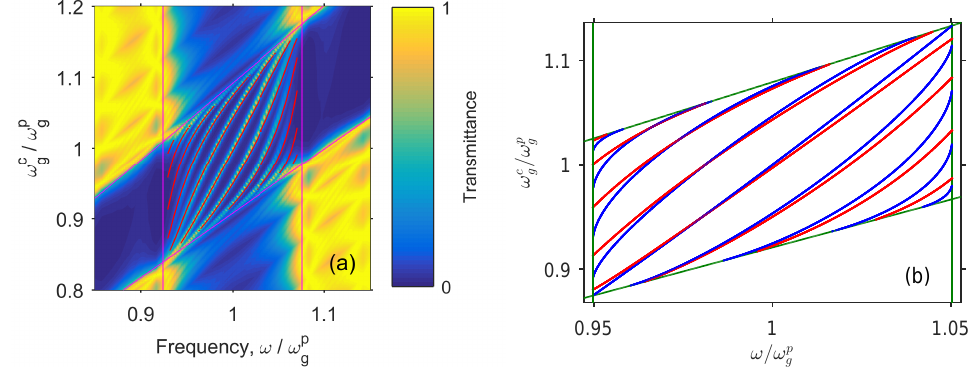
Figure 3. ( a ) The transmission spectra upon changing the pitch of the CLC helix and frequency shift of the center of its bandgap ω c g : The frequency of the center of the PPAM bandgap is ω p g = const . At ω c g / ω p g = 1, the parameters correspond to Figure 1. The angle between the optical axes of PPAM and CLC at the interface has the values within the range π /4 ≤ ϕ ≤ 5 π /4 with the step π /10. ( b ) Dispersion curves of chiral optical Tamm state (COTS): Axes are the same as in Figure 3a. In the overlapping area of the bandgaps, the solutions of Equation (8) are given taking into account Equations (1)–(5) for finite media—red color, and Equations (6) and (7) for semi-infinite media—blue color. The straight green lines denote the bandgap boundaries.